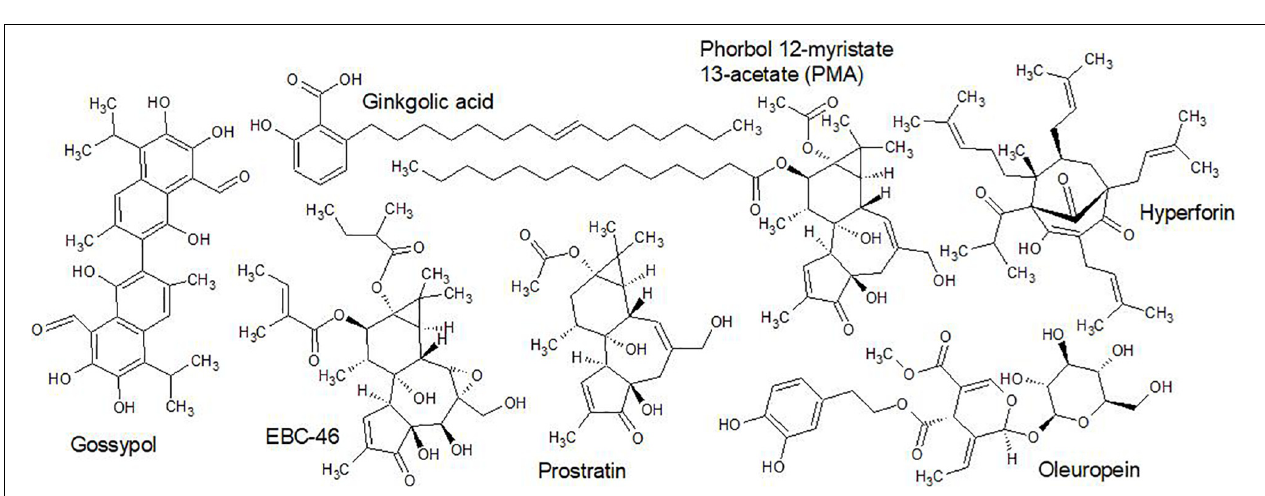
FIGURE 10 | Biosynthetic precursors to Vitamin D3 (top) and D2 (bottom). Vitamin D3 and D2 differ by their alkyl substituent branching from the 5 membered ring. This difference is also evident in the 1,25-dihydroxy derivatives, which are the active immunomodulatory forms. No research has yet elucidated salient differences in biological